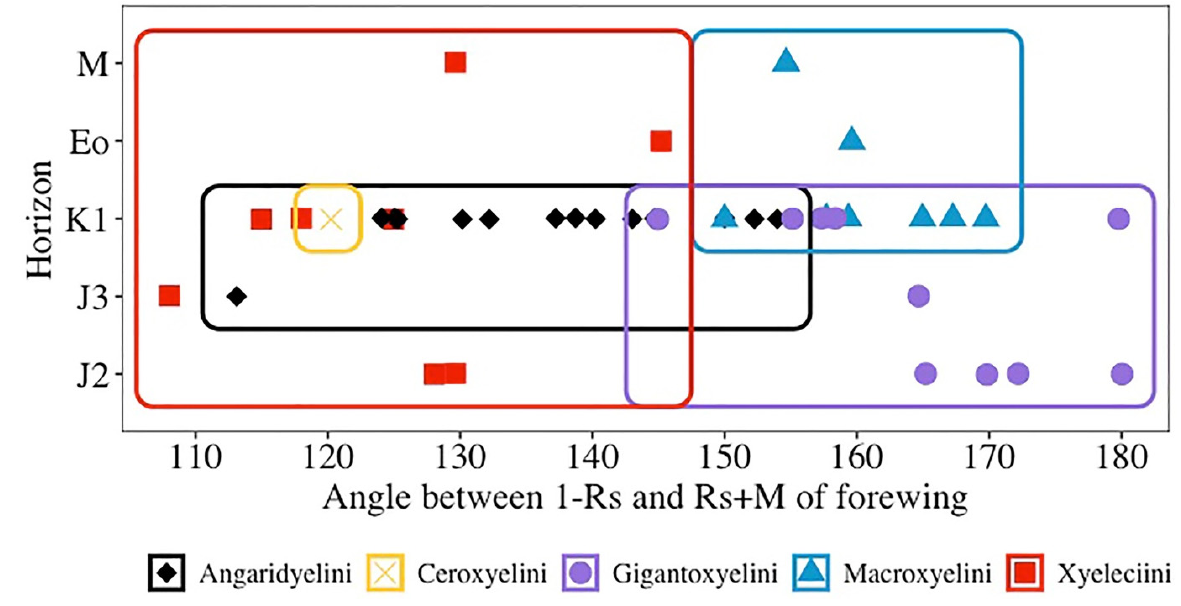
Figure 5. The changes of angle between 1-Rs and Rs+M of forewing for known fossil species of five tribes in Macroxyelinae and the relationship between the angle and fossil age. Angaridyelini in black; Ceroxyelini in yellow; Gigantoxyelini in purple; Macroxyelini in blue; Xyeleciini in red. J 2 —Middle Jurassic; J 3 —Late Jurassic; K 1 —Early Cretaceous; Eo—Eocene; M—Miocene.